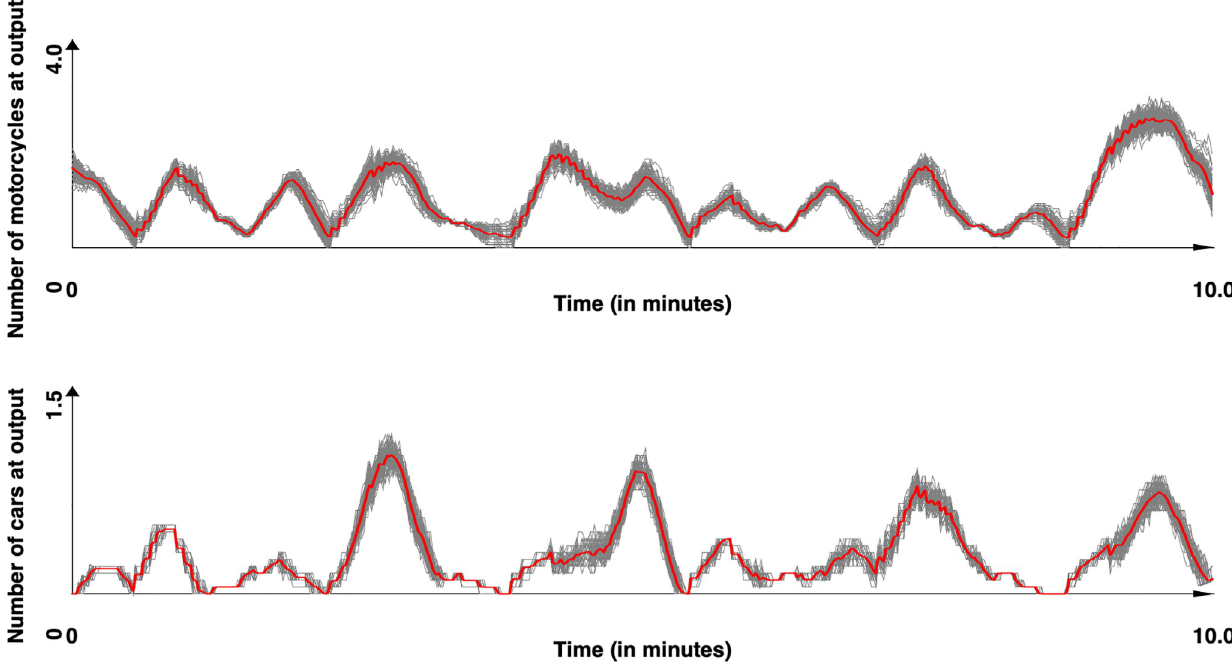
Fig 12. Simulated results for the Chua Boc site. Motorcycle and cars counts for the 100 simulations with our model (time series were smoothed out using moving average with a window size of 10s). In red, the mean values.